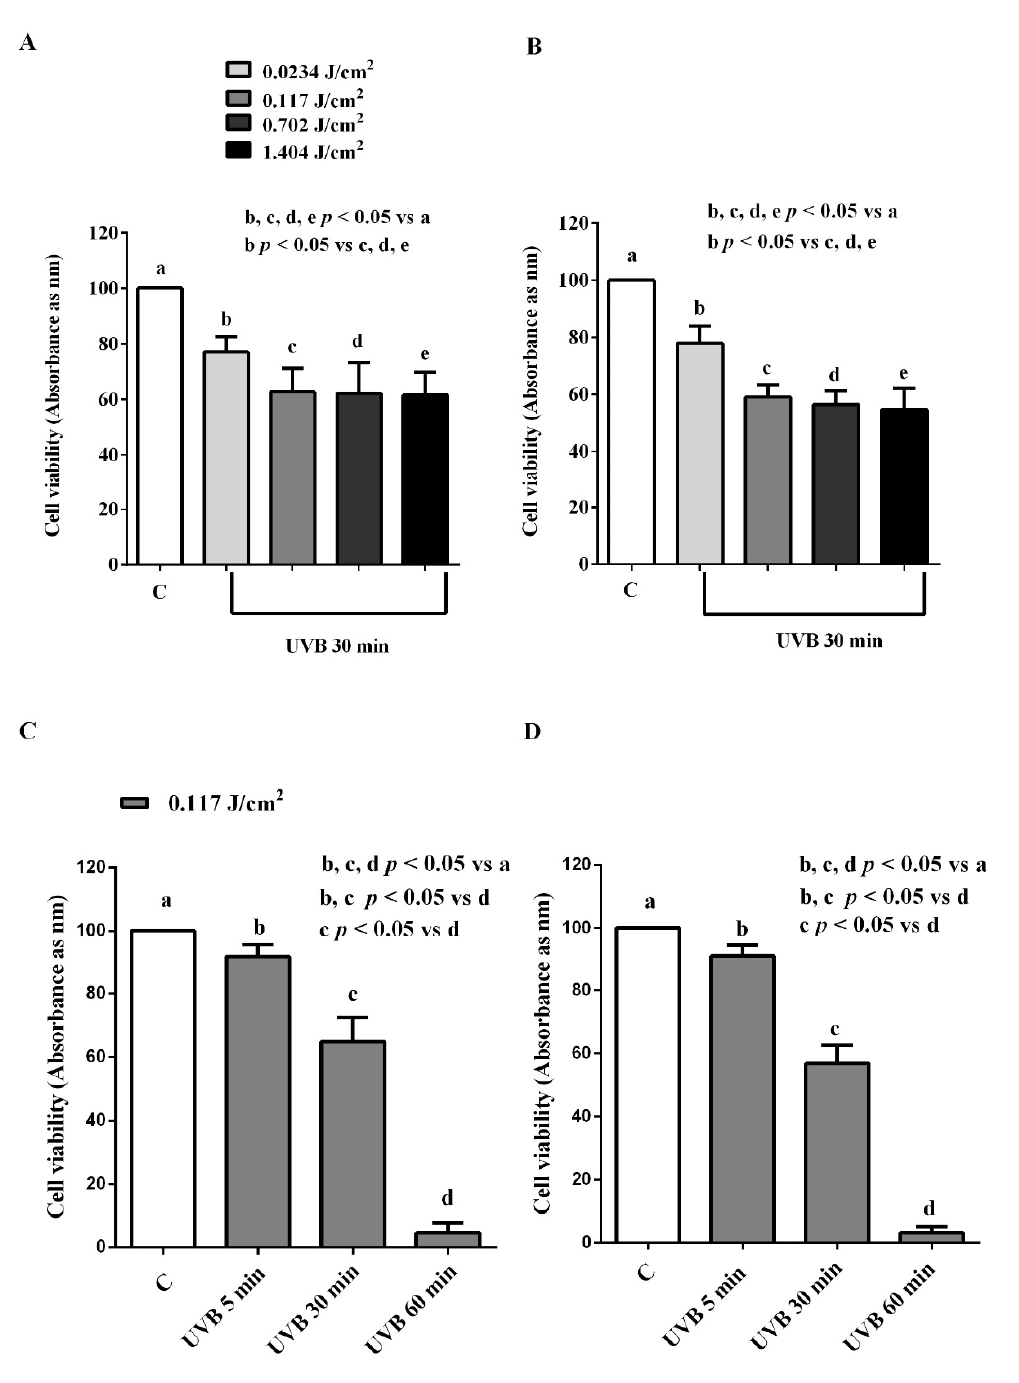
Figure 1. Dose–response ( A , B ) and time–course ( C , D ) effects of UVB on cell viability of ARPE-19 cells ( A , C ) and RGC-5 cells ( B , D ). The results are means ± SD of repeated experiments. C: control cells (non-treated).